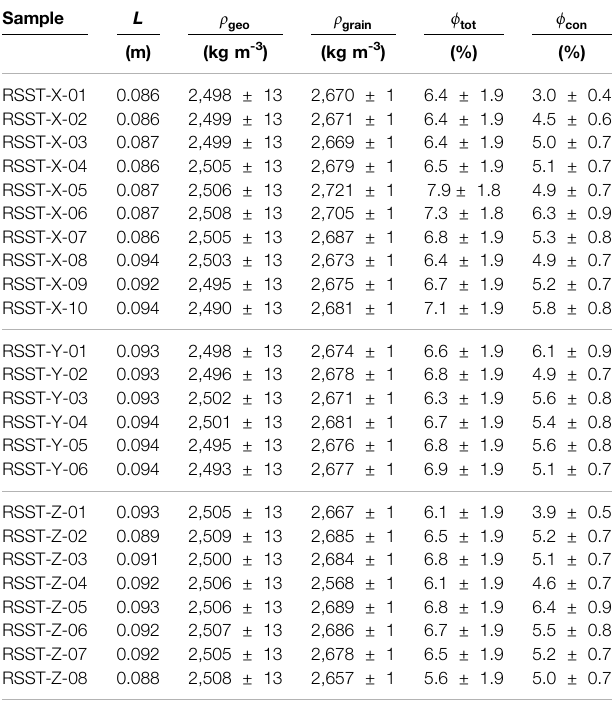
TABLE 1 | Matrix properties determined by laboratory measurements on Ruhr sandstone samples from the Oberste quarry in Dortmund. All measurements were conducted at ambient conditions. The abbreviations RSST and e.g., X indicate the rock sample Ruhr sandstone and the drilled direction from the parent cube,